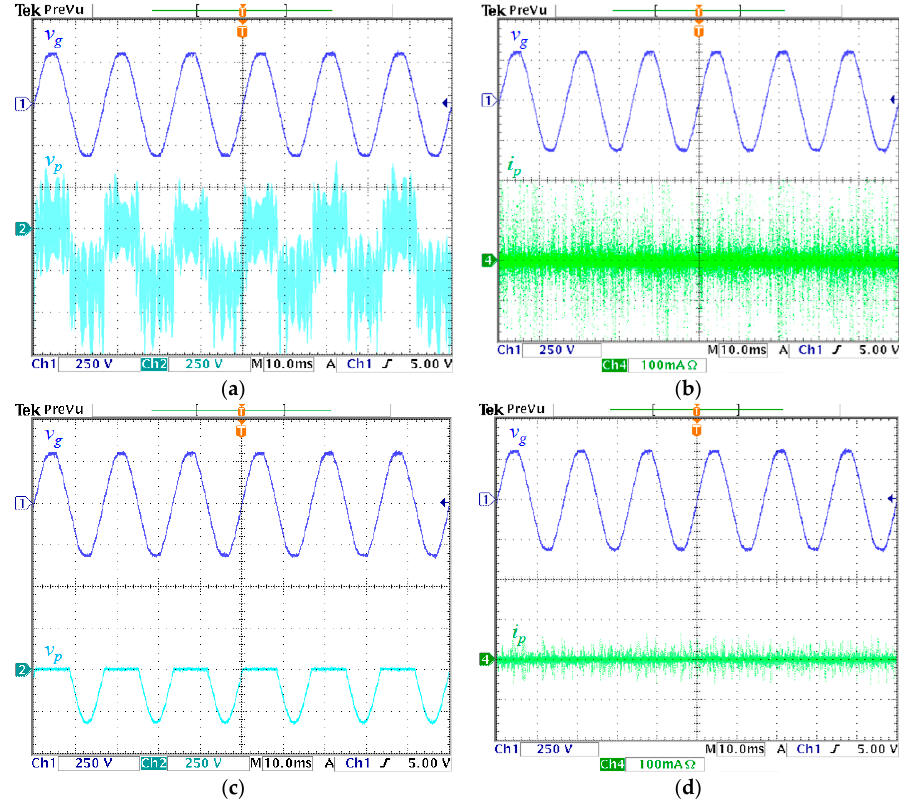
Figure 8. Experimental waveforms: ( a ) v g and v p in the conventional inverter; ( b ) v g and i p in the conventional inverter; ( c ) v g and v p in the proposed inverter; ( d ) v g and i p in the proposed inverter.